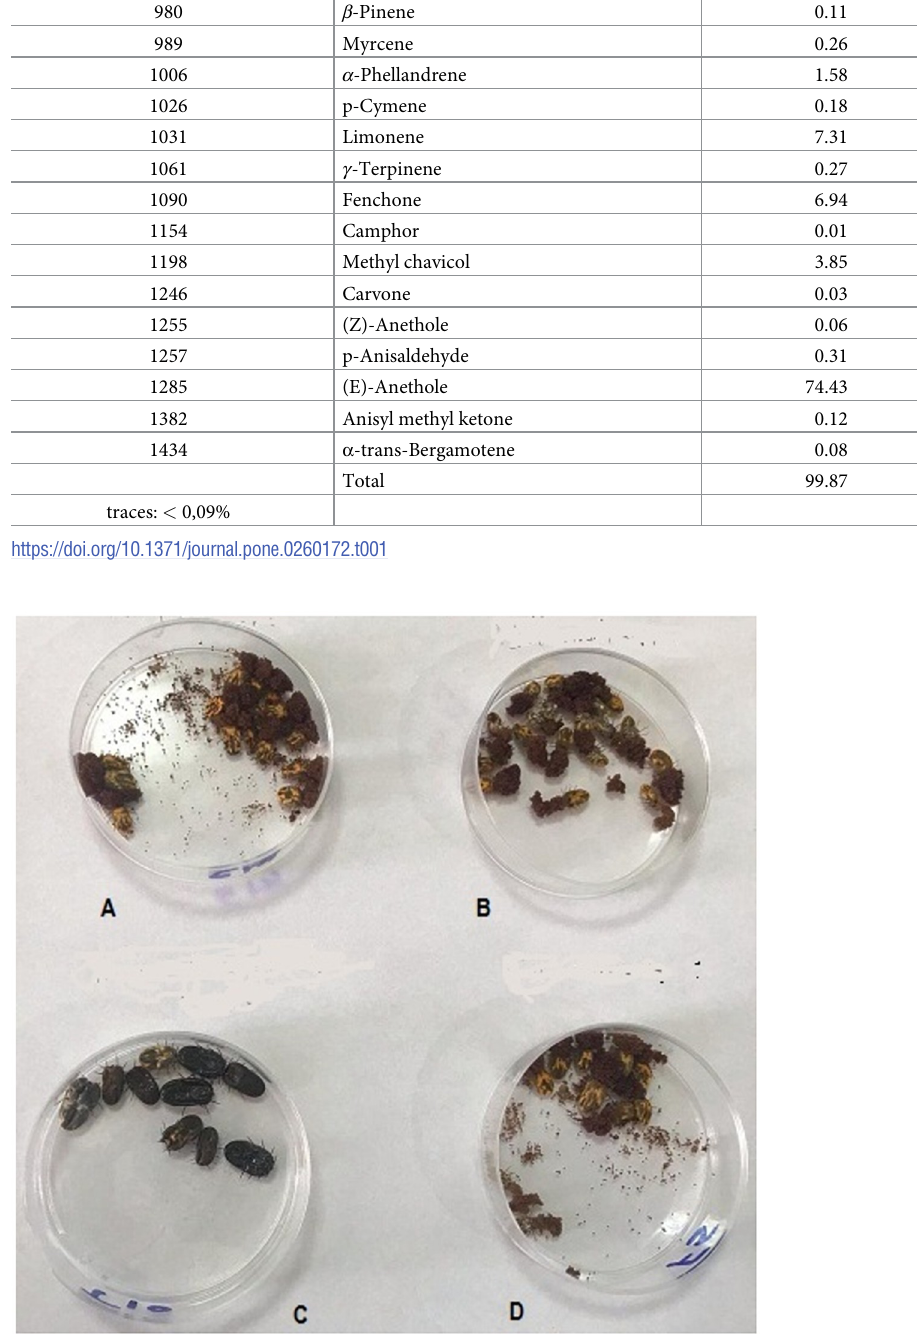
Fig 3. Adult Rhipicephalus annulatus ticks treated by different compounds at day 7 post treatments; A. Treated ticks by 70% ethyl alcohol deposited eggs, B. treated ticks by deltamethrin (1mL/L) deposited eggs, C. Dead ticks treated by trans-anethole 10%, D. Treated ticks by fenchone 10% deposited eggs.